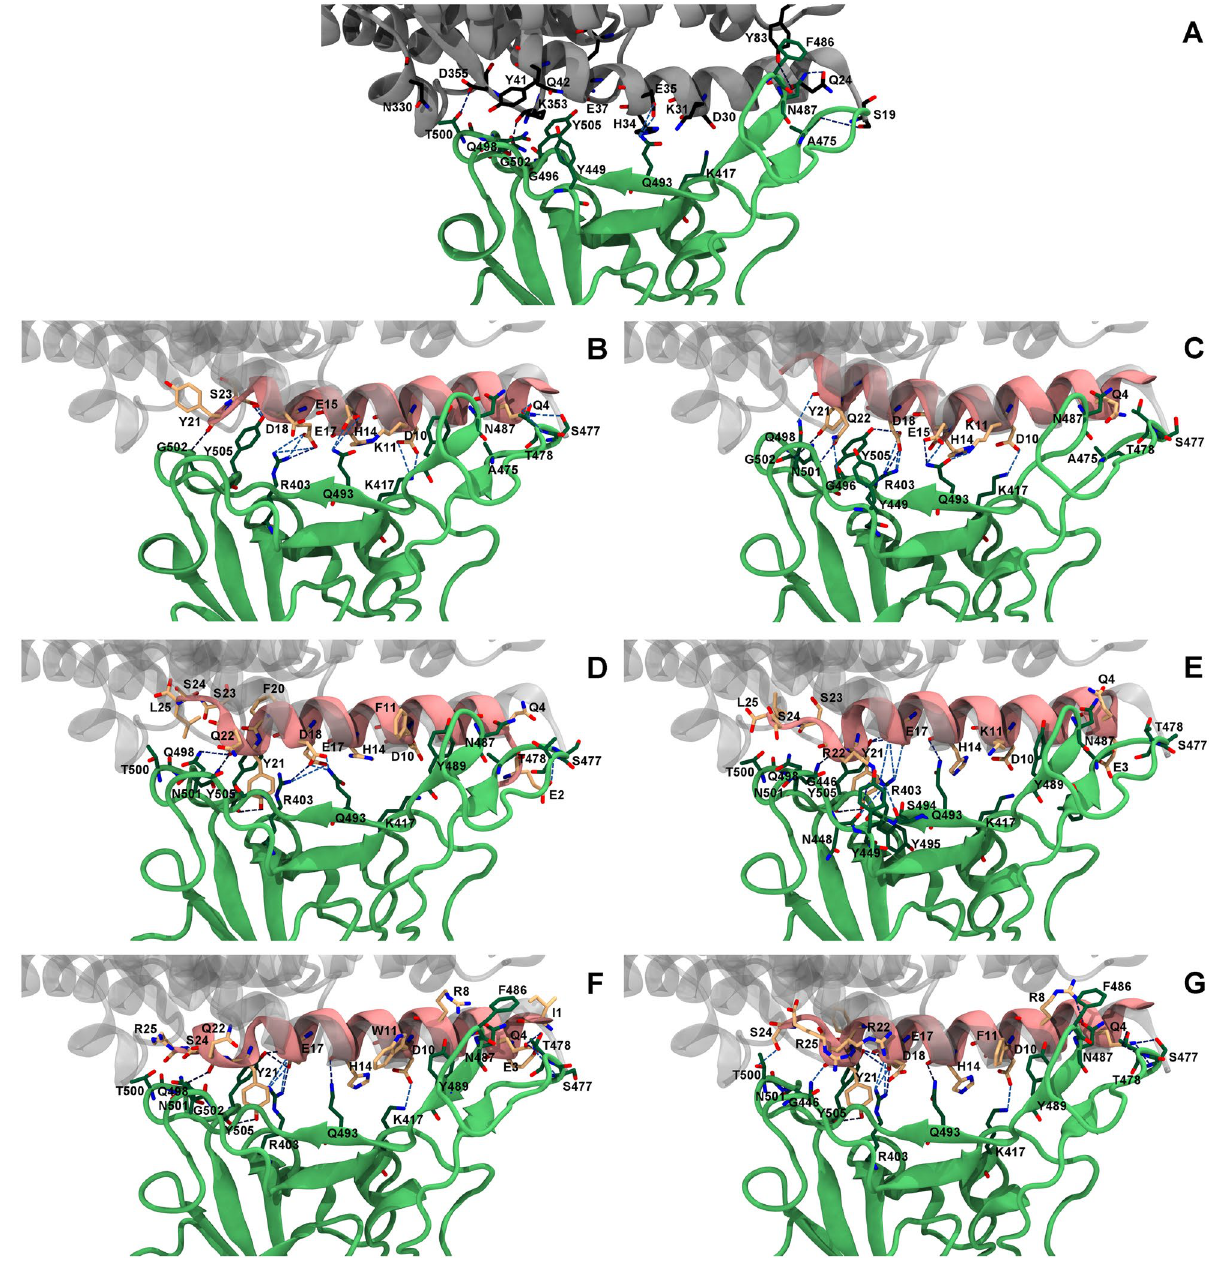
Figure 4. Key binding interactions between SARS-CoV-2-RBD (green) and ( A ) ACE2 36 , ( B ) SBP1 36 , ( C ) SPB25 36 , ( D ) SPB25 K11F , ( E ) SPB25 Q22R , ( F ) SPB25 F8R/K11W//L25R or ( G ) SPB25 F8R/K11F/Q22R/L25R . The structures of SBP1, SPB25 and designed peptides (pink) were superimposed with ACE2 (grey). Key hydrogen bonds and salt bridges (hydrogen bond occupations > 25%) are shown in blue dashed lines. These structures are the structures closest to the average structures from the 80–100 ns MD